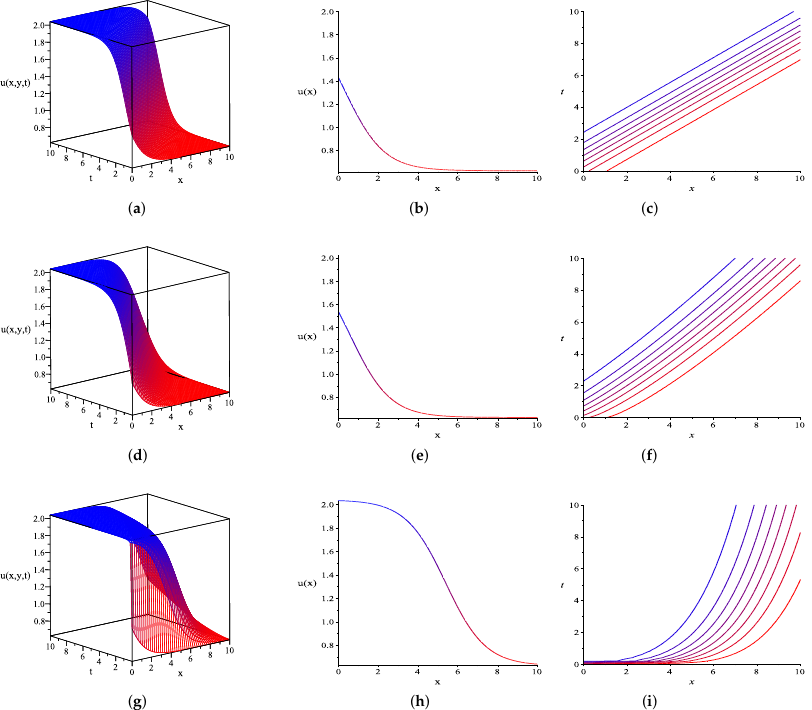
Figure 2. Associated plots of u 1 ( x , y , t ) in Equation (39) obtained using the generalized Kudryashov method: ( a – c ) 3-D plot, 2-D plot, and contour plot, respectively when α = 1; ( d – f ) 3-D plot, 2-D plot, and contour plot, respectively when α = 0.8; ( g – i ) 3-D plot, 2-D plot, and contour plot, respectively when α = 0.2.